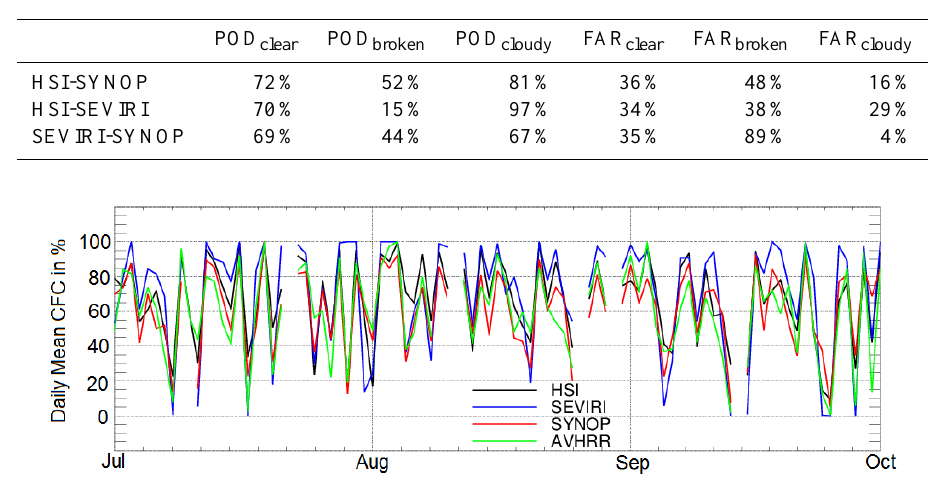
Figure 8. Daily mean CFC of HSI, SEVIRI, SYNOP and AVHRR in percent in Hannover from 1 July to 30 September 2009.